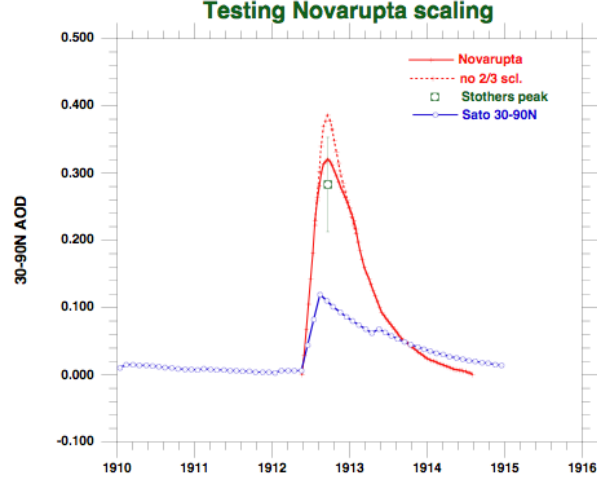
Figure 4. Supporting evidence of a shorter life cycle for high latitude eruptions based on Stother’s (1996) reanalysis of sur- face observations for 1912 Novarupta eruption and bimonthly- scale ECM ( µ Eqkg − 1 ) from the GISP2 ice core (Taylor et al., 1997, ftp: // ftp.ncdc.noaa.gov / pub / data / paleo / icecore / greenland / summit / gisp2 / ecm / ).